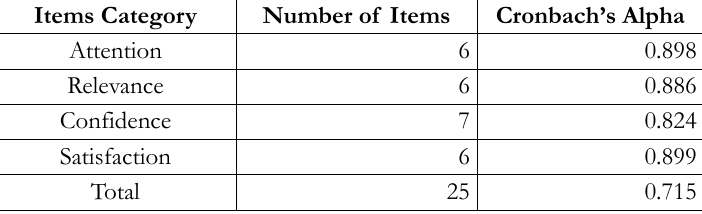
Table 1. Cronbach’s alpha measurements for the categories of SSM